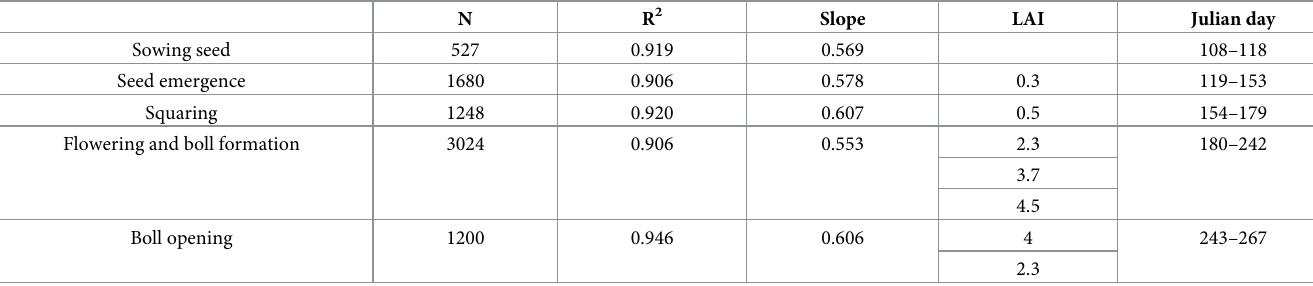
Table 5. LAI comparison for each of the growth stages.